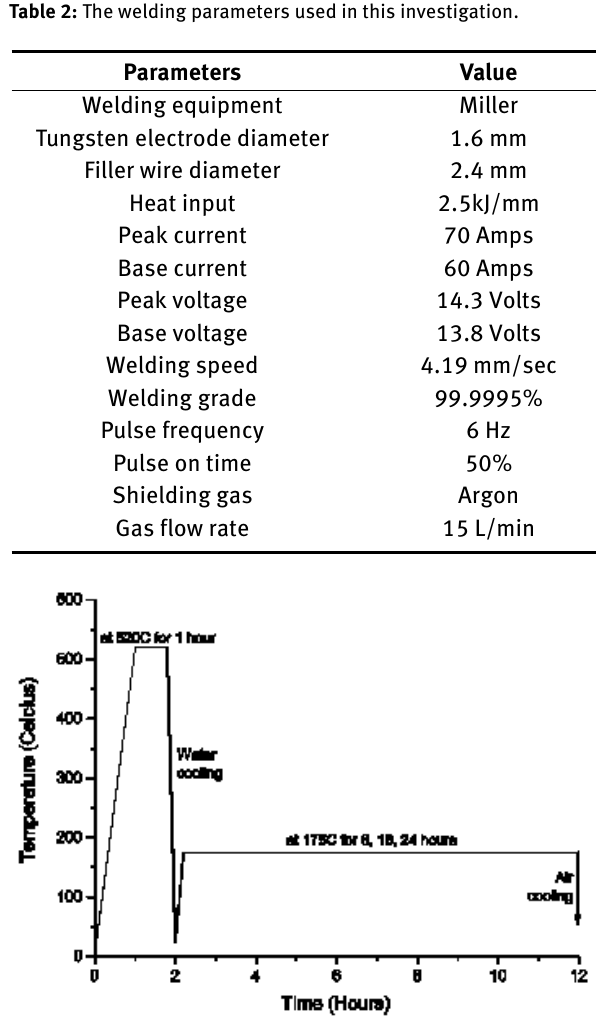
Figure 2: The PWHT (T6) process diagram. Figure 3: Welding profiles (BM, HAZ, and WM) across the plate and schematic illustration of microhardness test